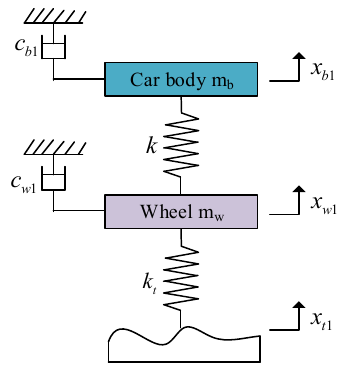
Figure 13. Reference model.